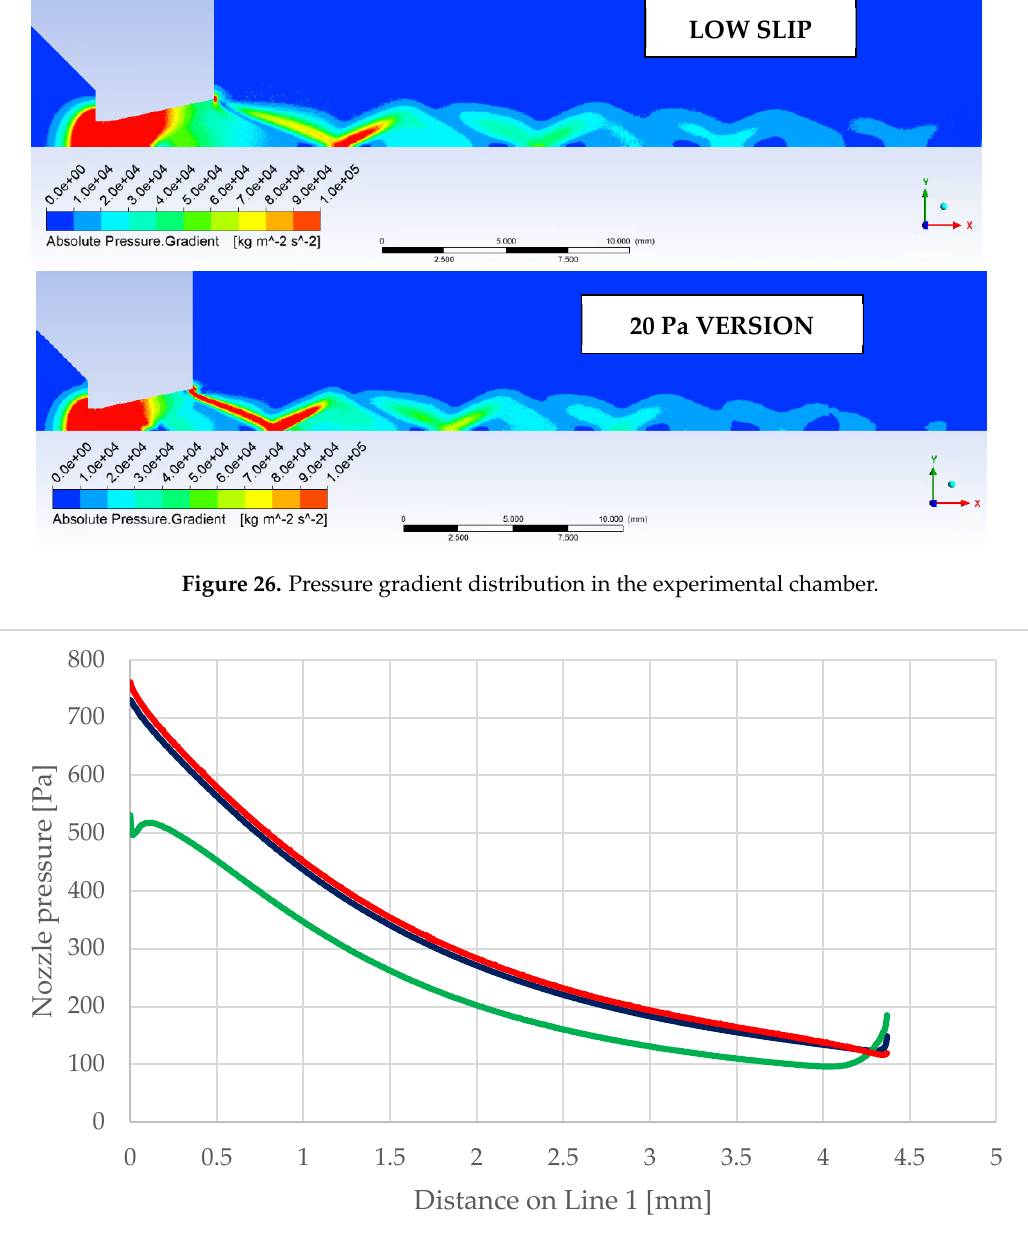
Figure 28. Distribution of reading points in the nozzle.